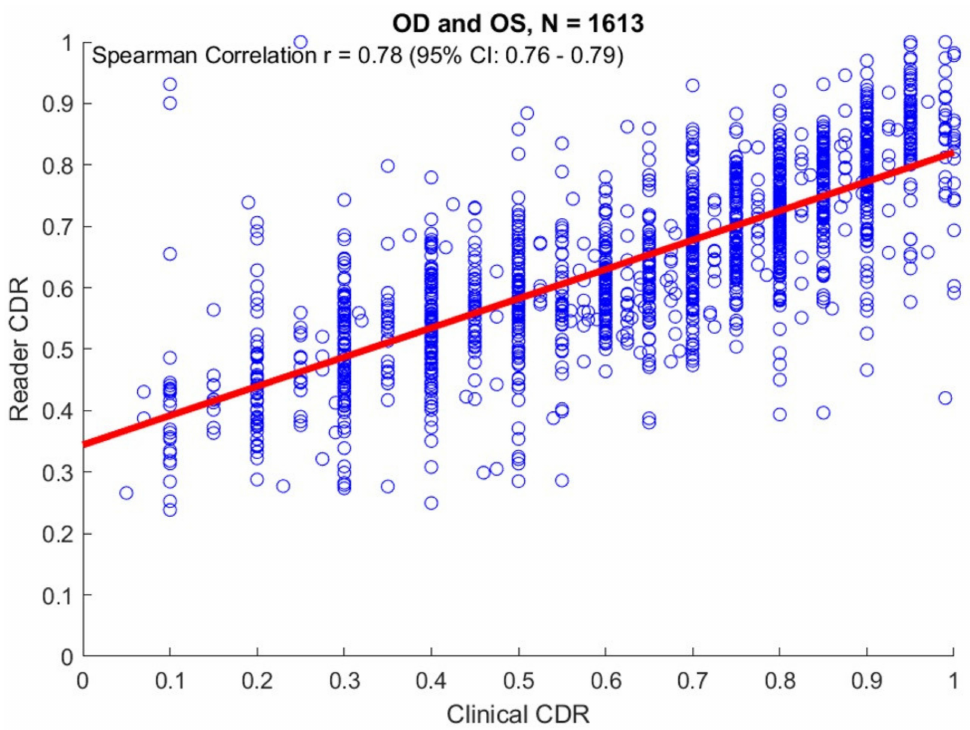
Figure 5. Correlation of vertical CDR measured by the trained readers versus clinicians, N = 161.